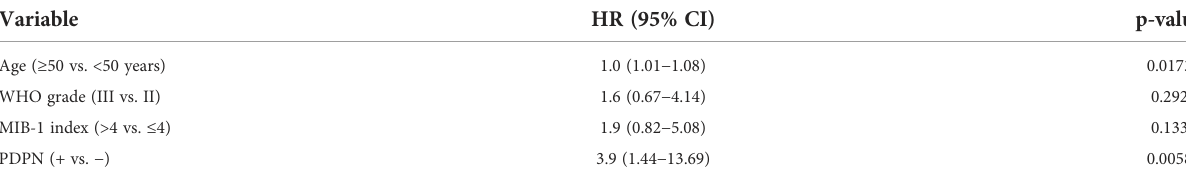
TABLE 3 Cox multivariate survival analysis for diffuse astrocytoma